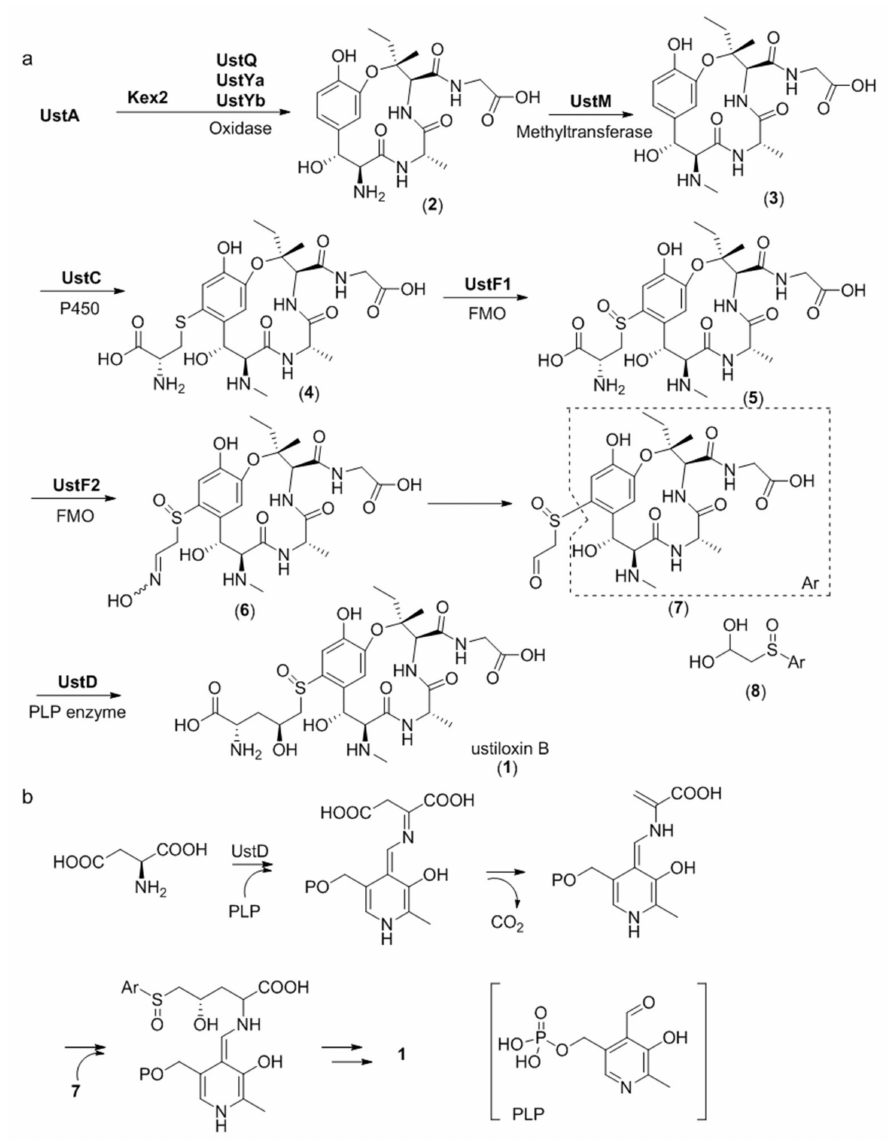
Figure 9. Proposed biosynthetic pathway for ustiloxin B. ( a ) Overall biosynthetic scheme, ( b ) Proposed mechanism of UstD catalyzed reaction. P450 = cytochrome P450 monooxygenase, FMO = flavoprotein monooxygenase, PLP = pyridoxal 5 (cid:48) -phosphate. Adapted from Reference [27].